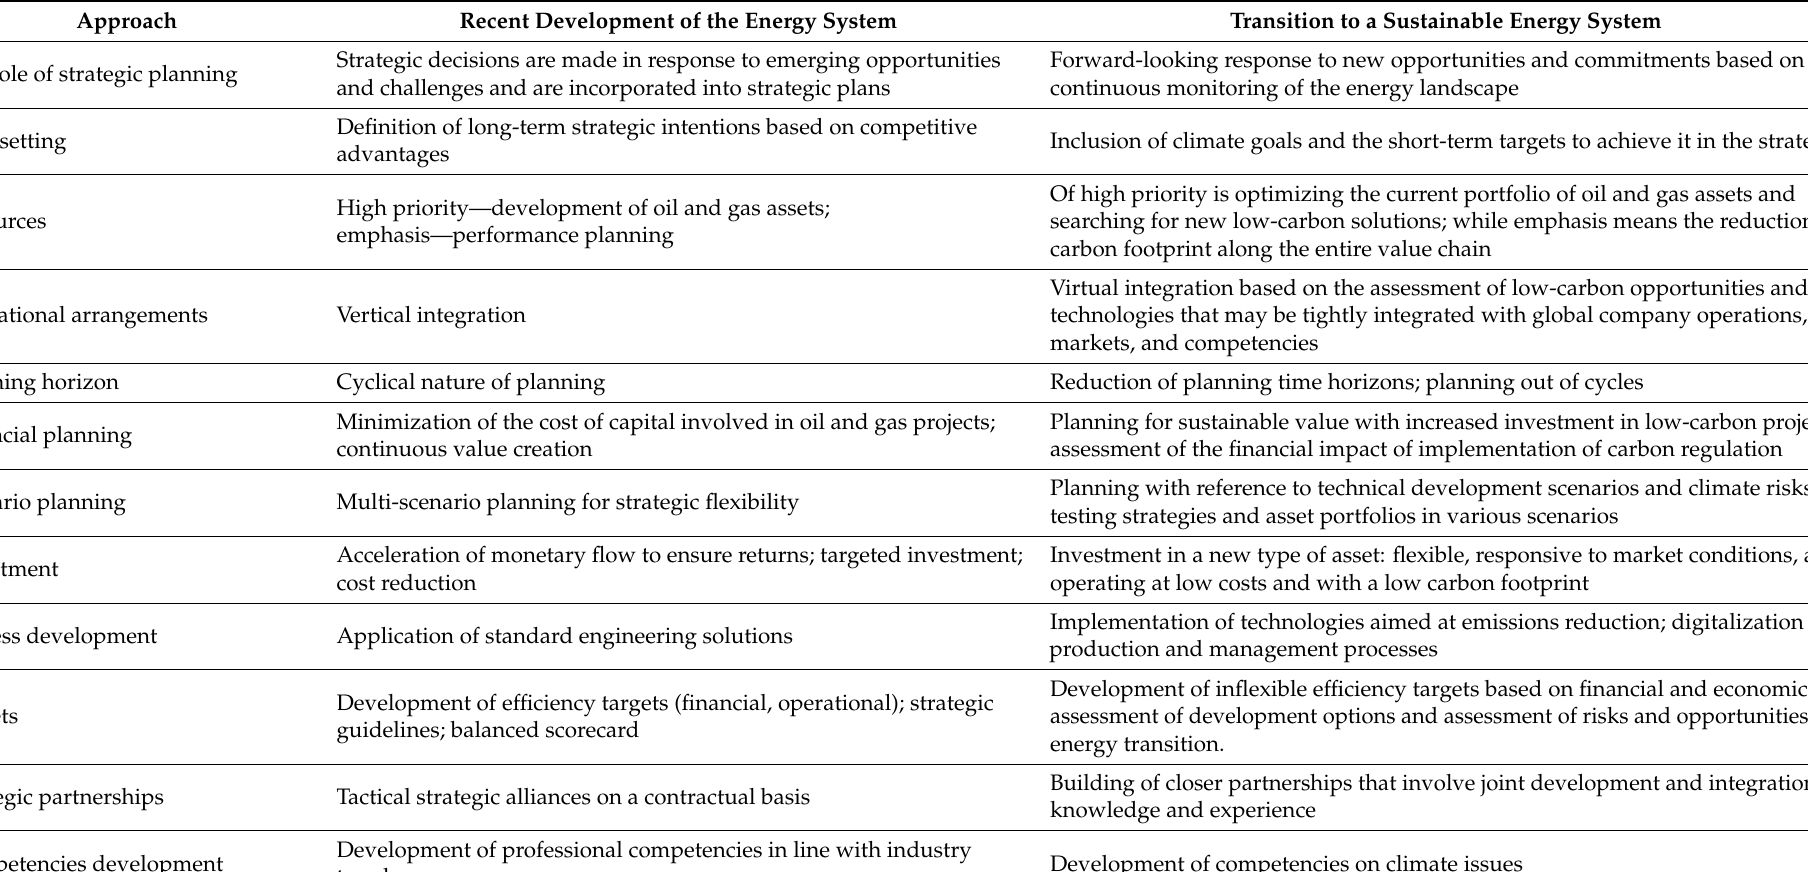
Table 2. Change of approaches to strategic planning of oil and gas